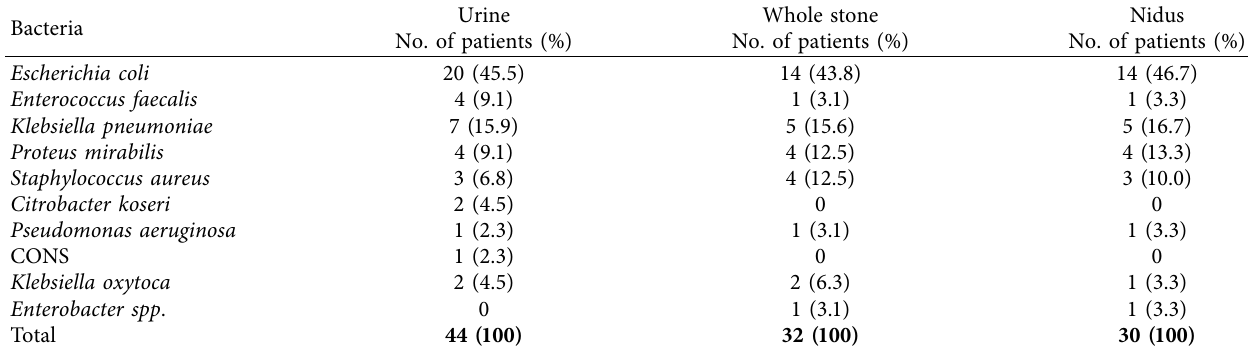
Table 1: Pattern of bacteria isolated from urine and stone matrices culture.